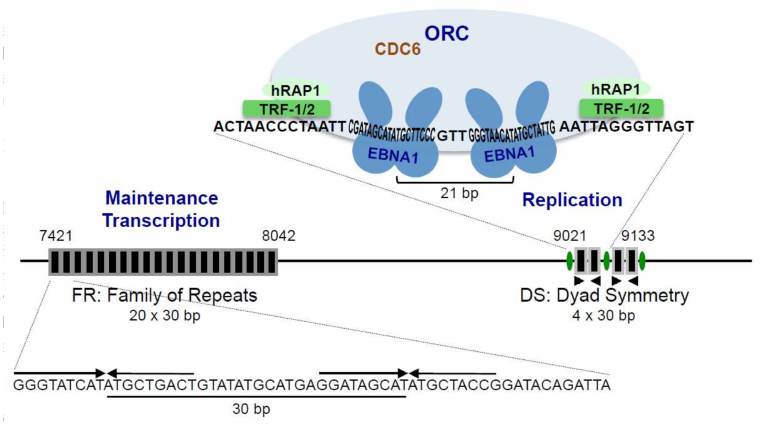
Figure 2. Schematic representation of EBV oriP. The EBV origin of plasmid replication (oriP) is composed of a family of repeats (FR), important for both EBV episome maintenance and EBV gene transcriptional regulation, together with the dyad symmetry (DS), important for viral DNA replication during latency. Individual DNA repeat elements within FR and DS, each carrying an EBNA1 binding motif, are represented by black boxes surrounded by grey outlines. Indicated genome coordinates are from the prototype B95-8 strain. Typical pairs of repeat elements derived from either FR or DS are enlarged to show the nucleotide sequence. EBNA1 recognition sites within FR are represented by head-to-head arrows above the sequence. Regarding DS, two dimers of EBNA1 bound to their DNA recognition sequence are represented (darker blue). The two dimers bind cooperatively to these sites and exact spacing between two EBNA1 binding sites has been found to be critical for origin activity. Binding of EBNA1 dimers to both sites induces a structural distortion of the DNA, probably important for oriP function. Regions of DS adjacent to each pair of EBNA1 recognition sites, carry binding sites for the telomere repeat binding factors, TRF1 and TRF2 (depicted in green) associated with human repressor activity protein 1 (hRAP1) (depicted in lighter green). Binding of these different factors onto the DS element contributes to the recruitment of the cellular origin recognition complex (ORC) (depicted in light blue) together with CDC6 (cell division cycle 6) onto the EBV